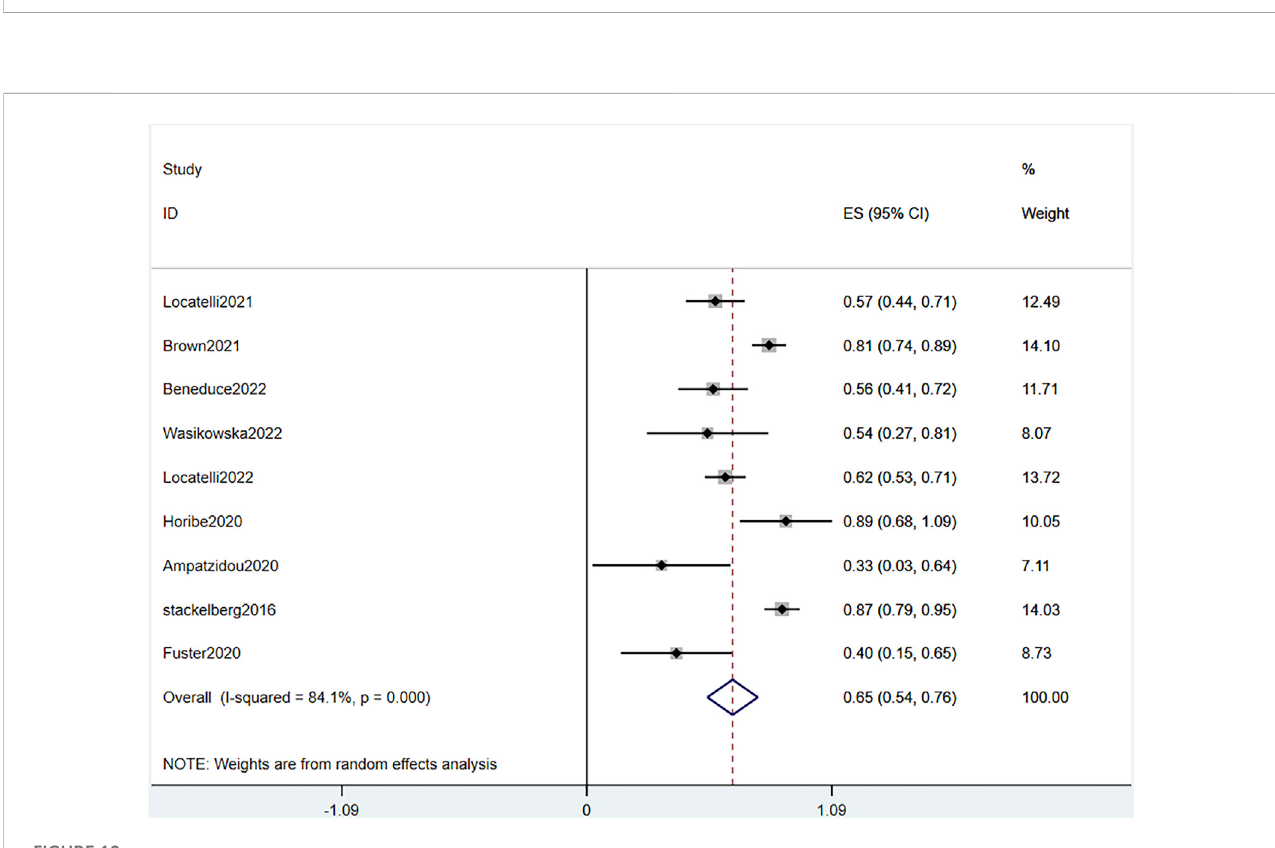
FIGURE 10 Forest plot of AE (single-arm studies). AE, adverse effects; 95% CI, 95% con fi dence interval; ES: Effect Size. The size of the rectangle at the center of the horizontal bar is proportional to the weight of the given study. The diamond at the bottom indicates the pooled